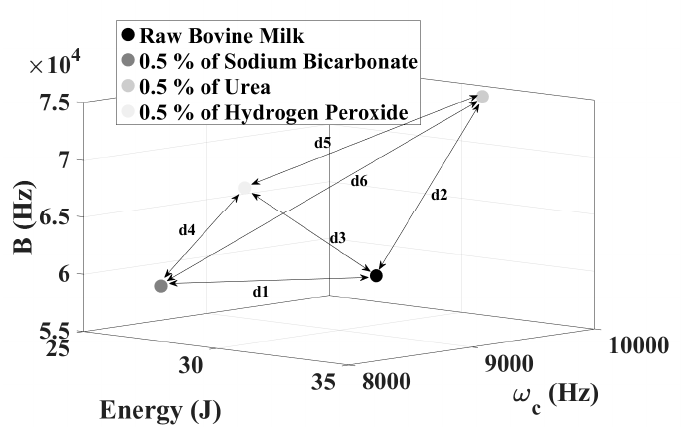
Figure 10. Average coordinates points and their distance of each contamination.